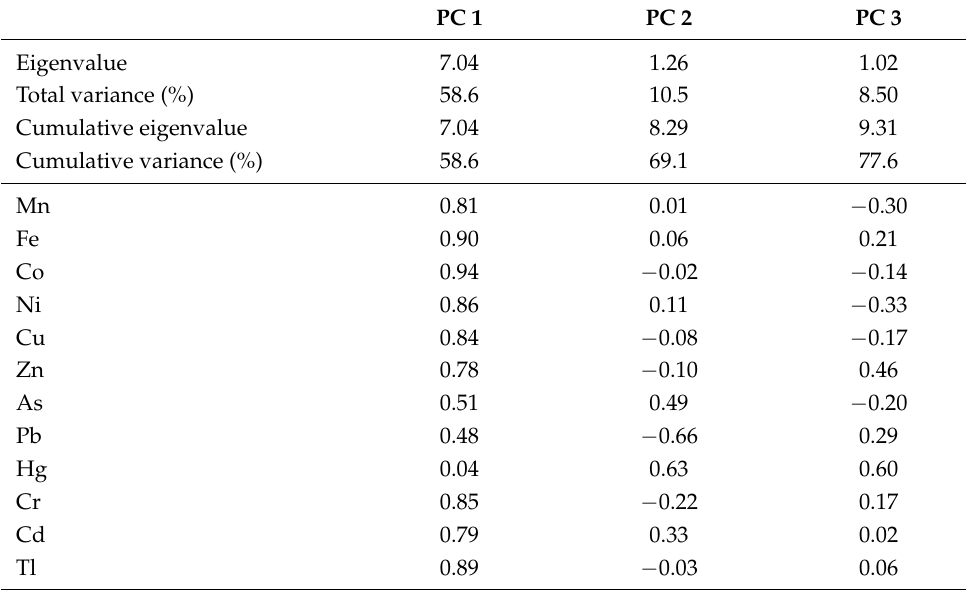
Table 3. Principal component analysis of selected metal levels in the